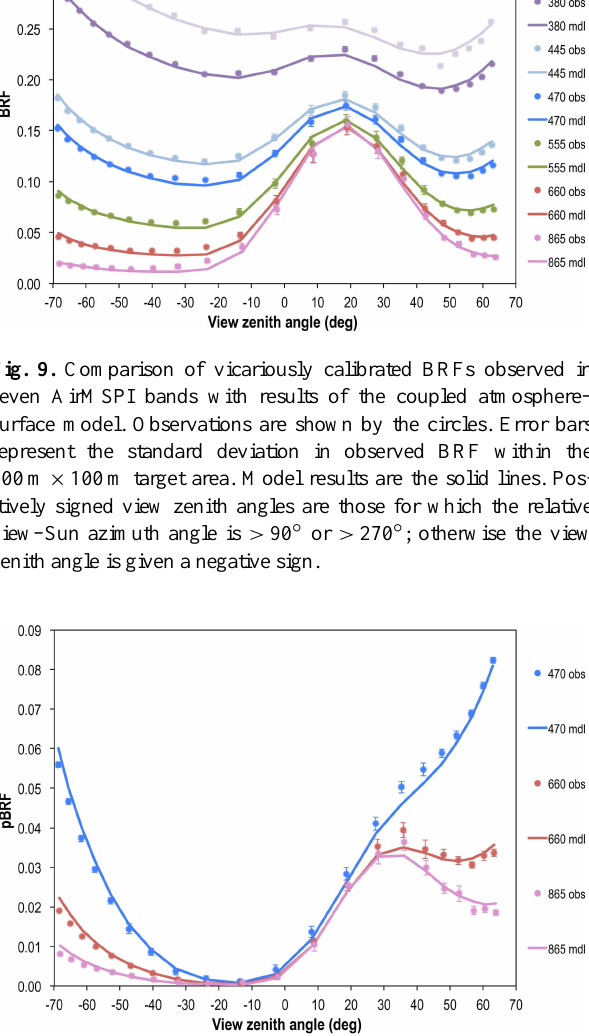
Fig. 10. Similar to Fig. 9 but for polarized BRFs in the three polari- metric AirMSPI bands.